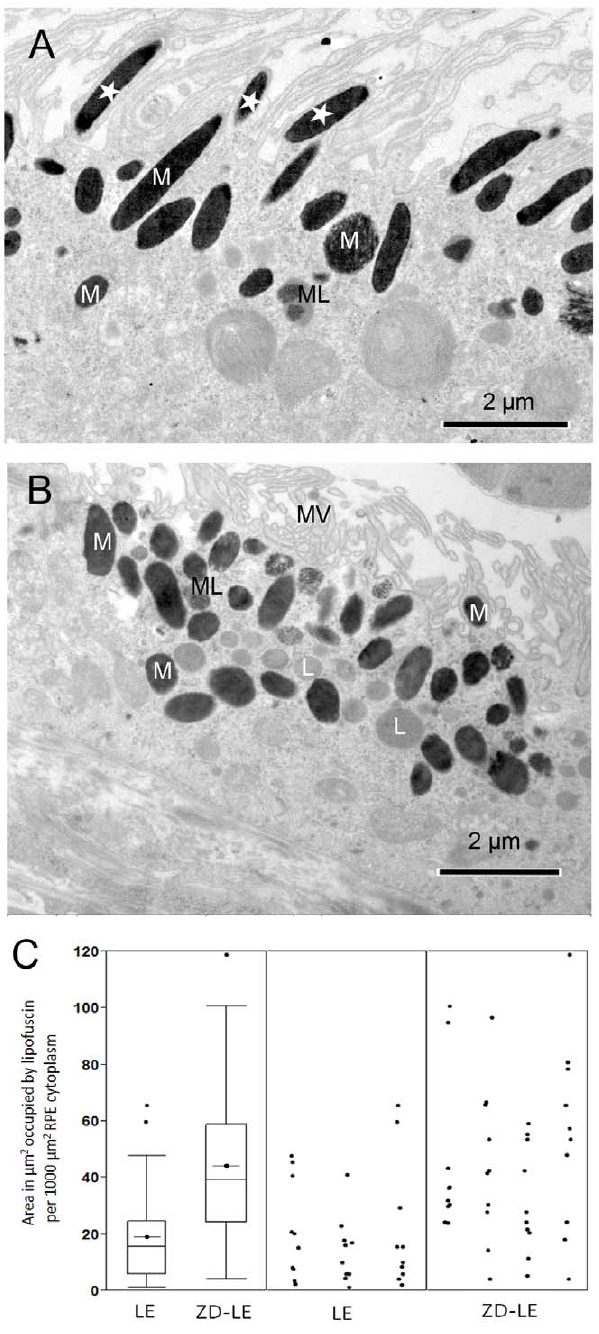
Figure 3. TEM micrographs of RPE cells of A) LE rat and of B) ZD-LE rat showing melanosomes (M), melanolipofuscin (ML) and lipofuscin (L) granules. In (B), note the rarefaction of melanosomes found normally in the RPE microvilli as seen in (A) (white asterisks). Note the crooked microvilli (MV) which covered a smaller area than typical upright positioned microvilli in control animals in (A). C ) Area fraction of lipofuscin granules in the RPE layer of LE and ZD-LE animals at ultrastructural level by using the iTEM image analysis software. The left side of the figure shows box plots with whiskers from minimum to maximum, the medians, outliers and also the means of the data (LE: 19 6 18 m m 2 vs ZD-LE: 44 6 28 m m 2 , p , 0.0001, Mann-Whitney test). The right side of the figure shows separately the quantification of the lipofuscin granules in each animal (three LE rat eyes and four ZD-LE rat eyes). Ten micrographs per eye were used to determine the area